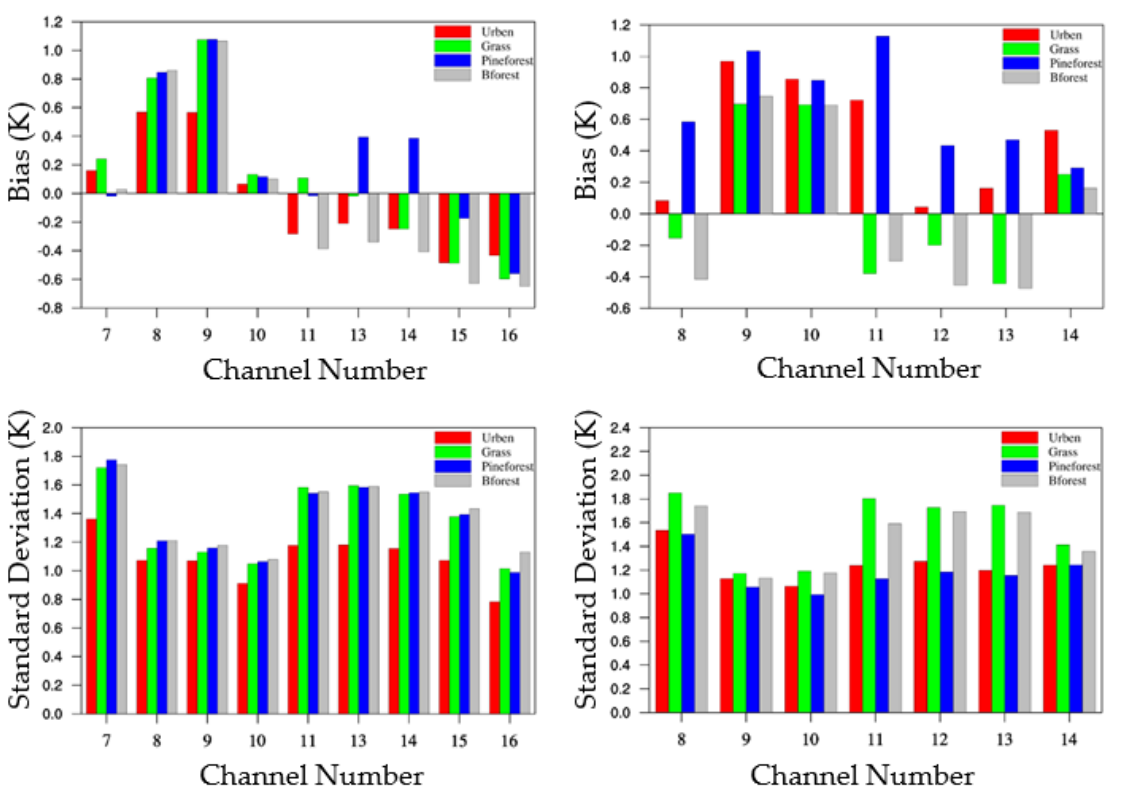
Figure 6. Mean ( top ) and standard deviation ( bottom ) of O-B for four vegetation types, urban (red), grasslands (green), pine forests (blue) and broadleaf forests (grey), identified under different AHI (left column) and AGRI (right column) channels.